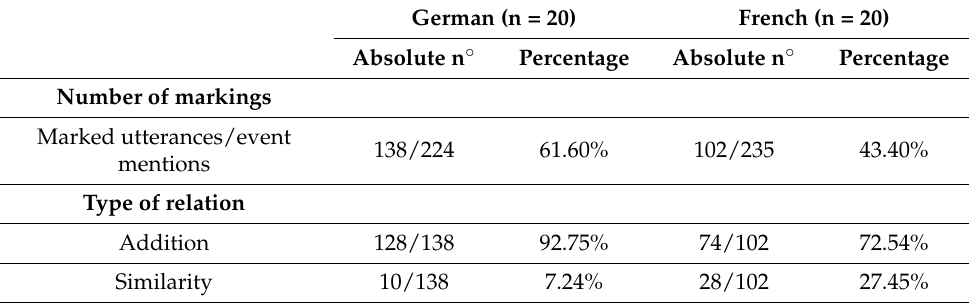
Table 3. Proportion of marked utterances in native productions.